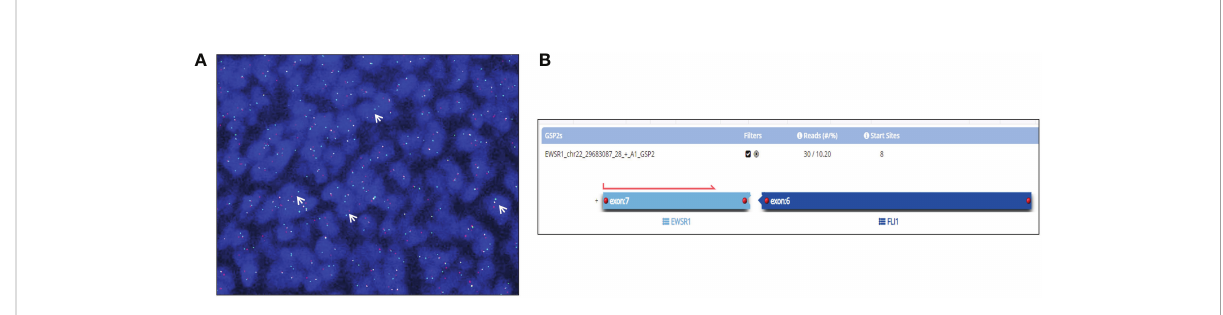
FIGURE 3 FISH with an EWSR1 Dual Color Break Apart Rearrangement Probe detected EWSR1 translocation in 80% of tumor cells as orange and green spitting signals (white arrows) (A) . Pan Solid Tumor v2 NGS analysis revealed the gene fusion involving exon 7 of EWSR1 and exon 6 of FLI , detected by a gene speci fi c primer (GSP2) speci fi c for EWSR1 (B)